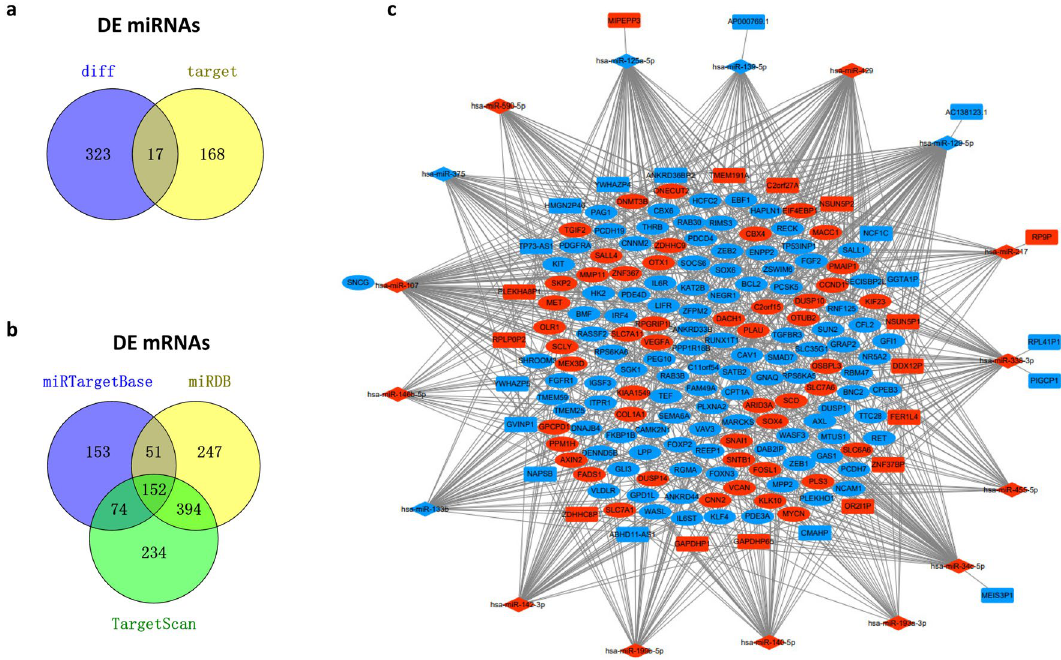
Figure 2. Construction of the ceRNA network for DE pseudogenes-miRNA-mRNA. ( a , b ) the overlapping DE miRNAs and mRNAs in different databases. ( c ) the ceRNA network. Round rectangles represent pseudogenes, diamonds represent miRNAs, and ellipses represent mRNAs. Blue represents downregulated genes, while red represents upregulated genes.